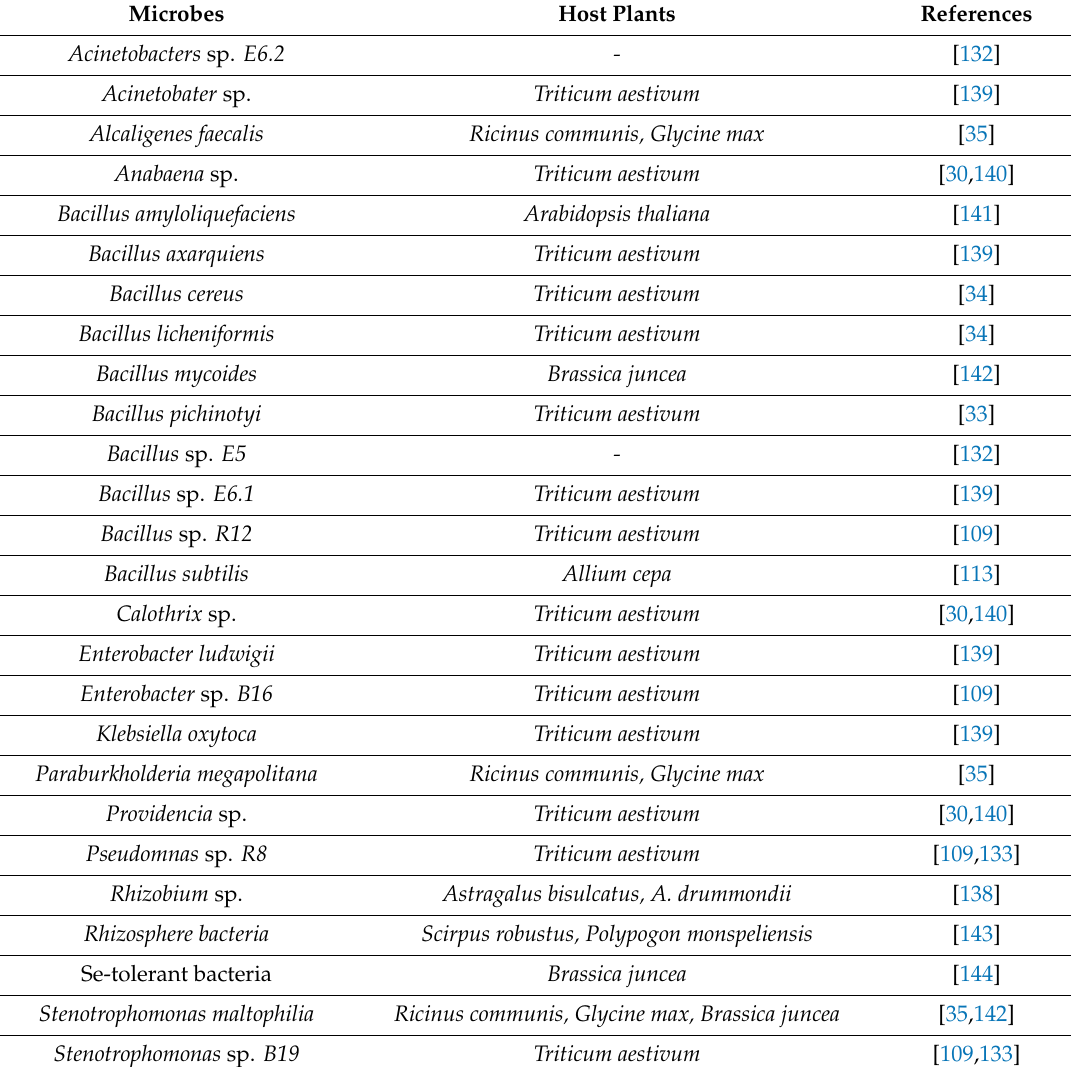
Table 2. Plant growth-promoting rhizobacteria (PGPRs) often used for Se biofortification. Host